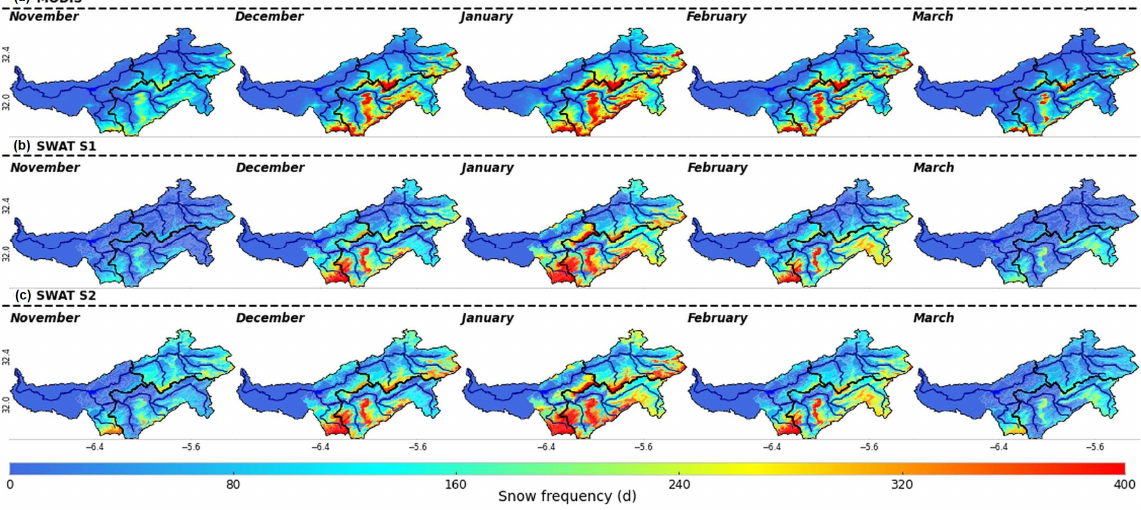
Figure 5. Occurrence frequency of snow during the period between 02/2000 and 12/2014. ( a ): MODIS, ( b ): SWAT S1, ( c ): SWAT